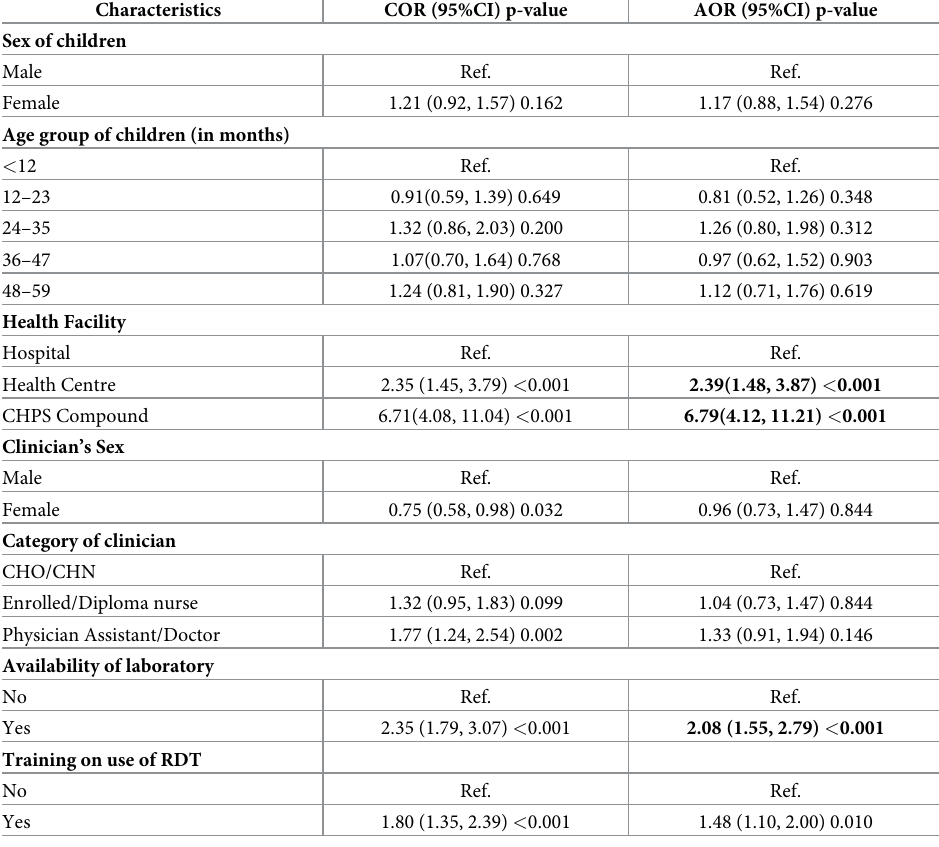
Table 3. Association between socio-demographic characteristics and other risk factors of study participants and the odds of completing T3.